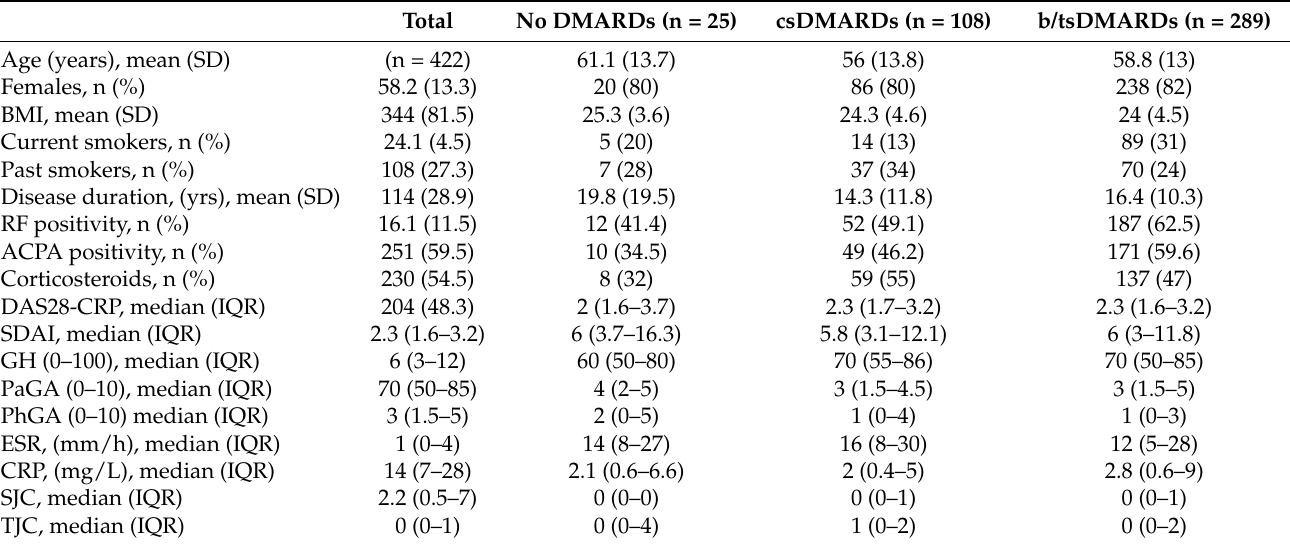
Table 1. Demographic and disease patient